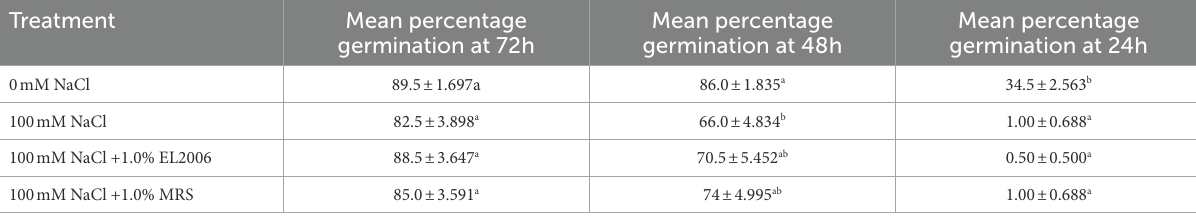
TABLE 2 Effect of treatments on mean percentage germination of soybean, at 72, 48 and 24 h, respectively. Treatment